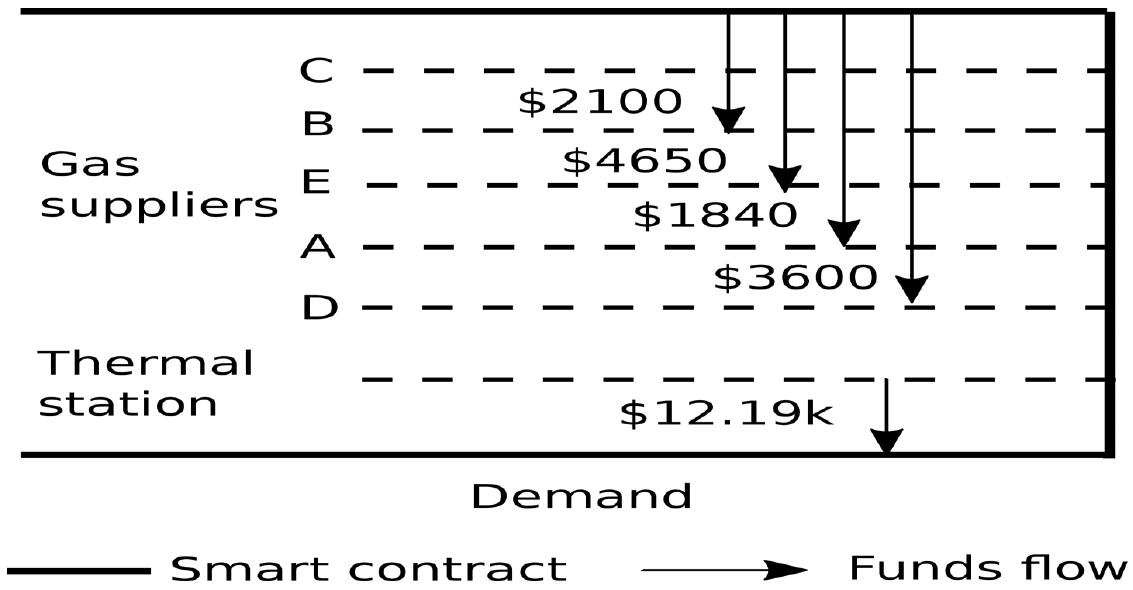
Figure 4. Smart contract execution of payments for the proposed P2P gas trading scheme.